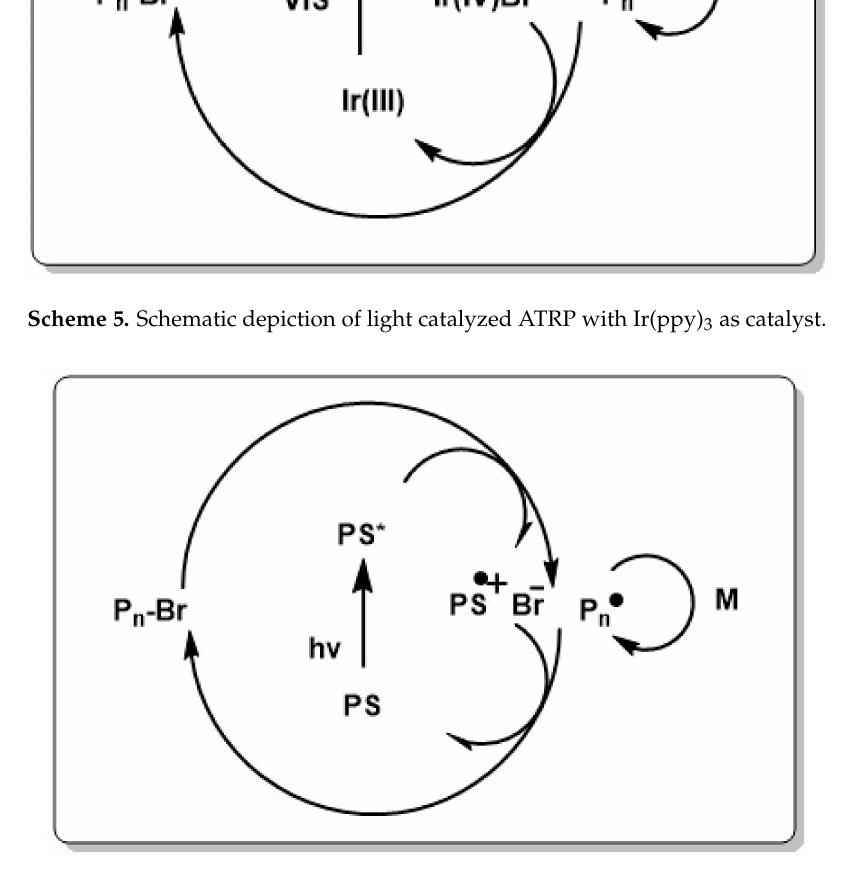
Scheme 6. Schematic depiction of the oxidative quenching mechanism in metal free